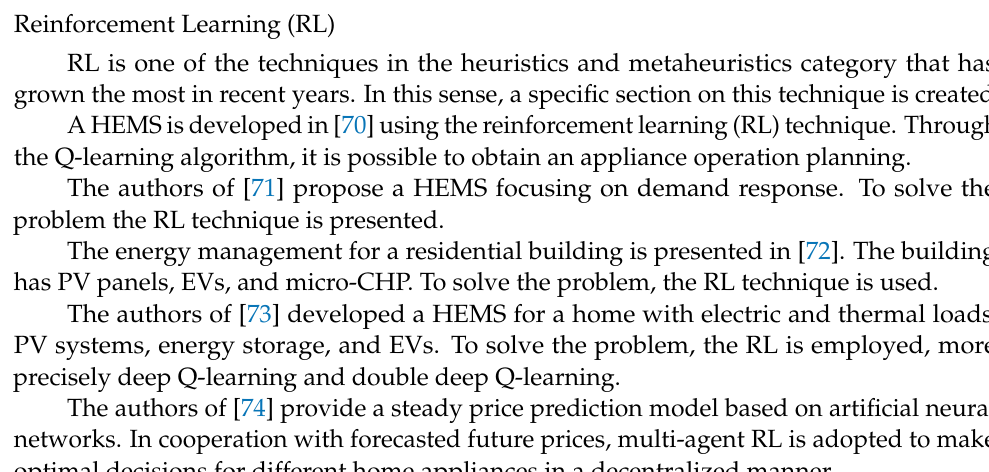
Figure 10. Number of selected papers associated with a given objective for heuristics and metaheuristics excluding reinforcement learning.